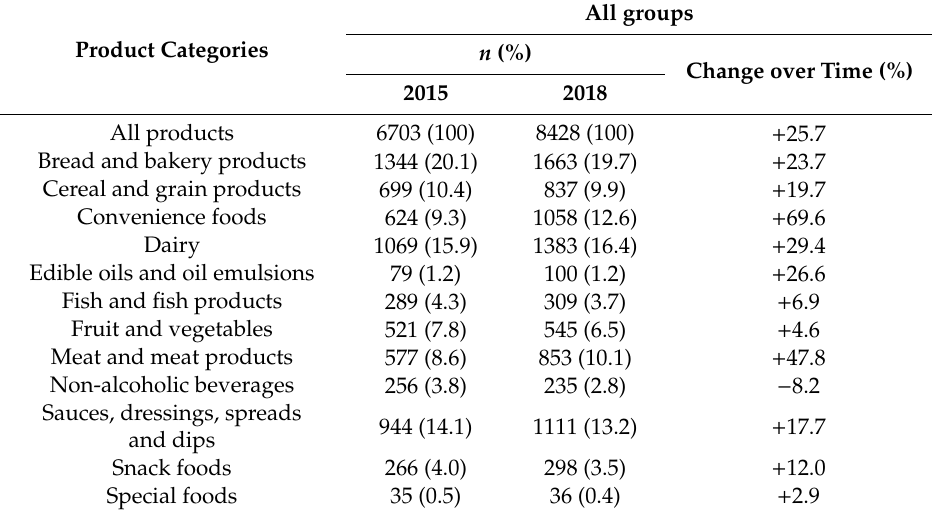
Table 1. Number (per cent) of all products and specific product types available in each